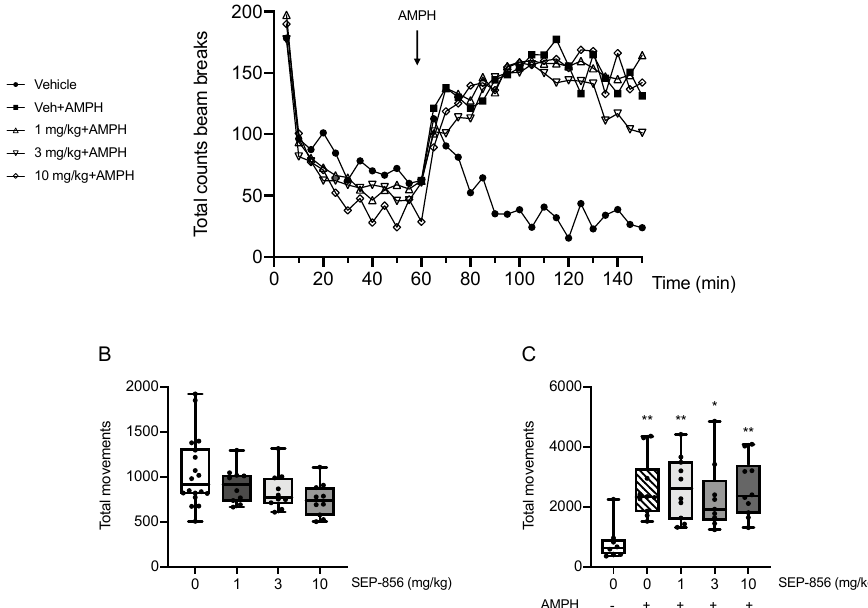
Figure 5. Analysis of total locomotor activity. Total locomotor activity counts over 150 min ( A ). The first 60 min show locomotor activity after treatment with SEP-856 (1, 3 & 10 mg/kg, p.o.) or vehicle. At 60 min rats received acute injection of AMPH (0.1 mg/kg, i.p.) or vehicle, as indicated by the arrow, and locomotor activity was measured for further 90 min. The total activity was measured over the first 60 min ( B ) pretreatment with different doses of SEP-856 (1, 3, 10 mg/kg) and over the 90 min period ( C ) following AMPH administration. Data are represented as box-and-whisker plots of at least nine independent determinations ( B and C) . For each box, the box boundaries indicate the first and third quartiles, the middle line specifies the median and the whiskers represent the lowest and highest values. * p < 0.05, ** p < 0.01 vs. vehicle-treated rats (one-way ANOVA followed by Tukey post hoc comparison).